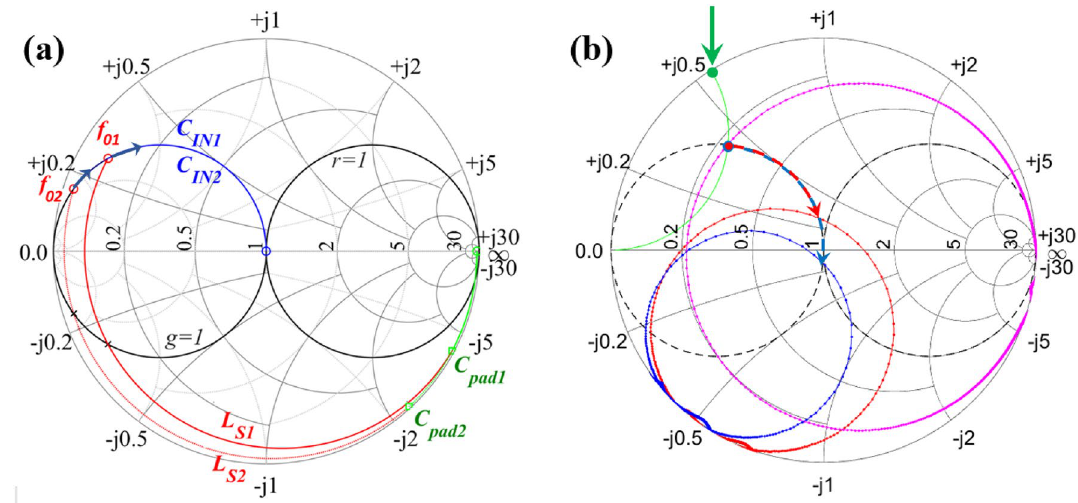
Figure 5. ( a ) The impedance trajectory sketch showing how to obtain the matched load. Green arcs represent the resulting effect of pad capacitance C pad added in parallel with DUT. Two cases are shown for two different values of pad capacitance, with a shorter green arc corresponding to a smaller C pad . ( b ) Experimental results obtained using ECD. Magenta arc represent the result of reflectometry measurement shown in Fig. 4 for 3.6 K. Green line towards the periphery follows the constant susceptance curve and reaches the edge of the Smith chart at the point indicated by a green dot and green arrow. This value of susceptance is used in calculation of required C IN = 24 pF which moves the impedance to the center of the Smith chart (blue arrows). Blue arc—experimental data for C IN = 27 pF; red arc— C IN = 20